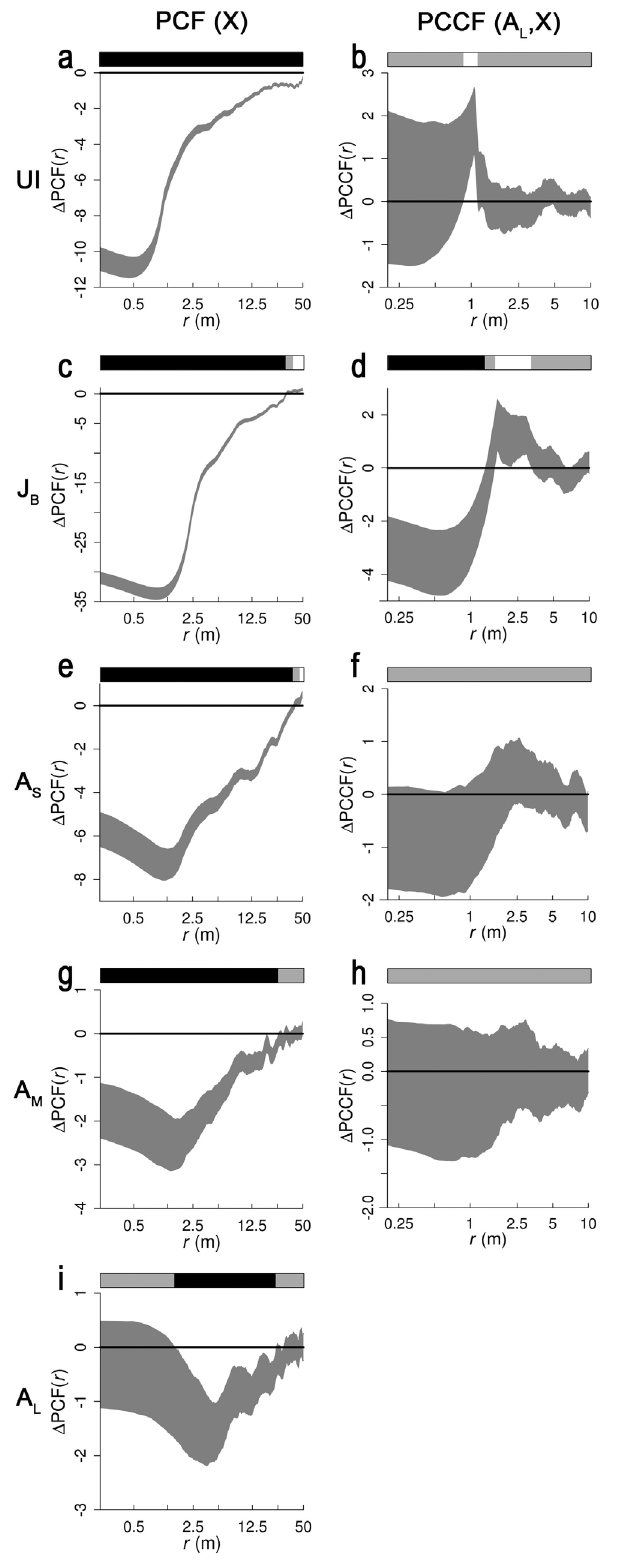
Figure 5. Spatial second-order summary statistics of five size classes, alone (univariate), and related to the large adult R. stricta pattern (bivariate). The left panels display the PCFs of the five size classes, while the right panels list the PCCFs between the large